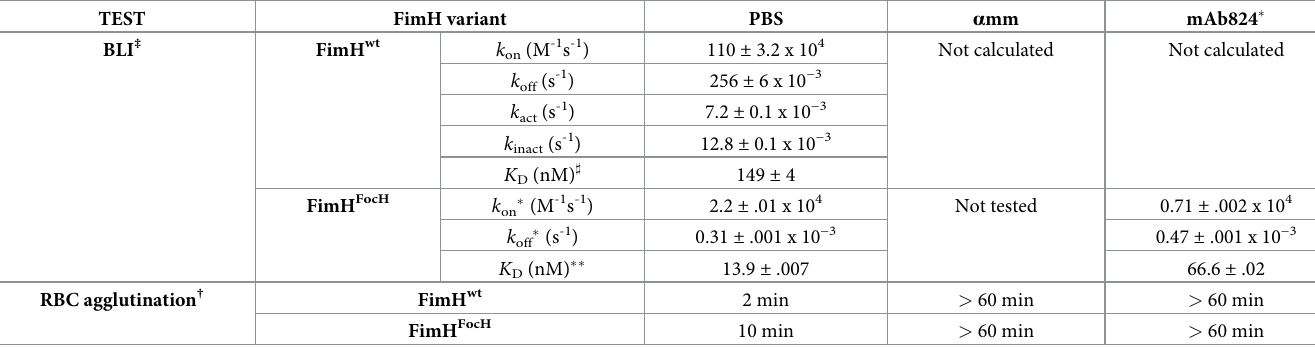
Table 1. Binding properties of FimH wt and FimH FocH